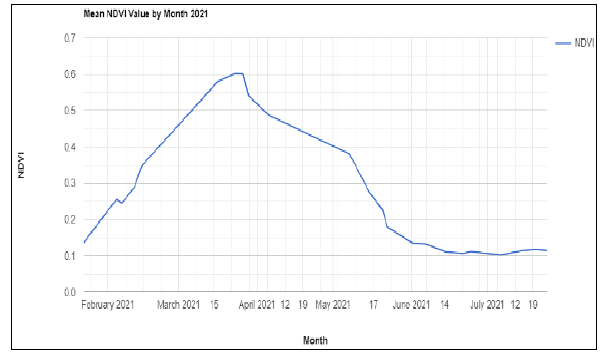
Figure 7 . NDVI profile during the growing period